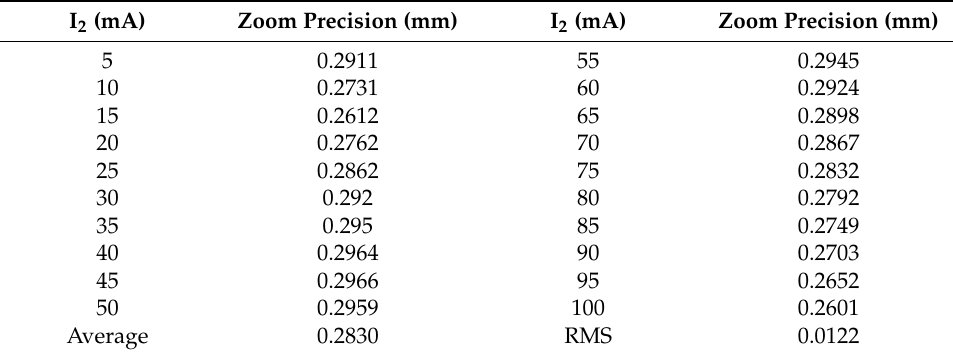
Table 3. Simulated zoom precision of the zoom system.